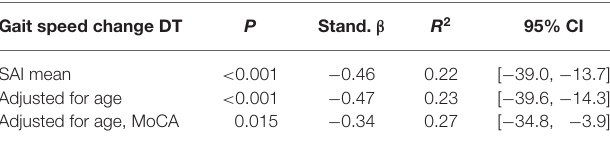
TABLE 2 | Regression model statistics and coefficients of variables for dual task cost for walking speed (PD, OLD-F and OLD-NF) . Gait speed change DT